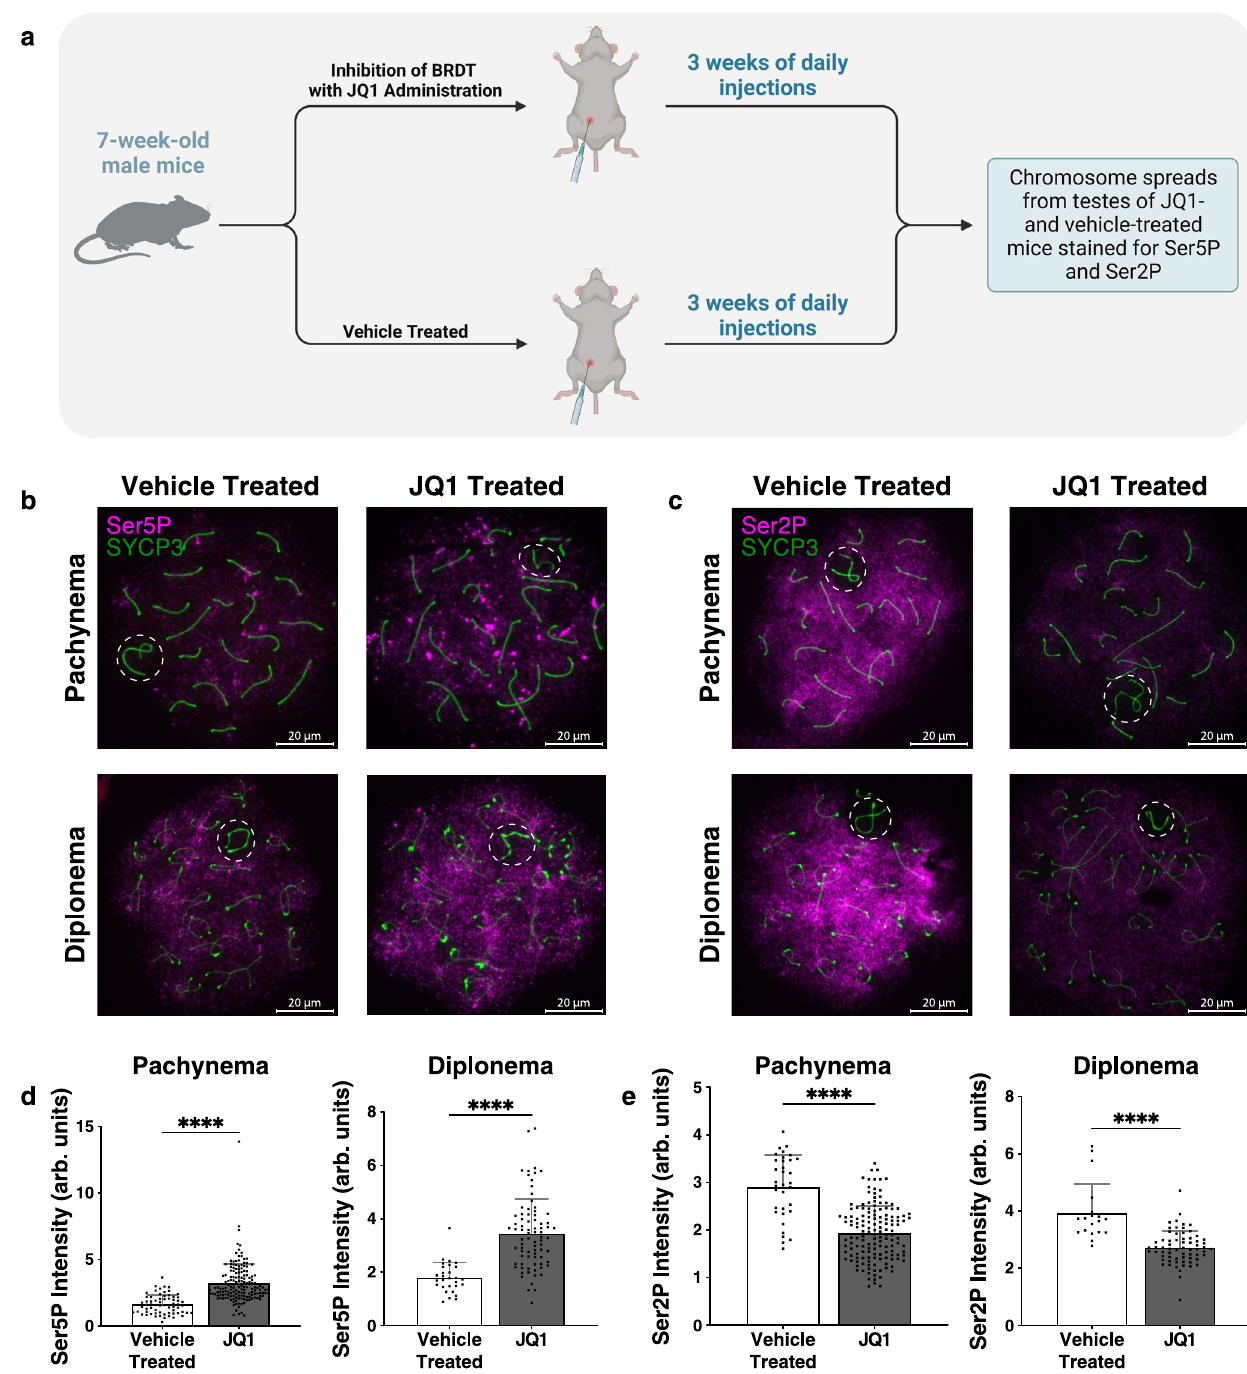
Fig. 5 | BRDT inhibition with the small molecule, JQ1, results in altered Pol II pause-release.a Schematicof experimentaldesignforinhibitionof BRDTwiththe smallmolecule,JQ1.7-week-oldmalemicewereinjectedintraperitoneally(i.p.)with JQ1 or vehicle solution daily for 3 weeks. Created with BioRender.com. b , c ImmunolocalizationofSYCP3(green)andSer5P( b )andSer2P( c )(magenta)in pachytene (top) and diplotene (bottom) spermatocytes from JQ1-treated and vehicle-treated male mice. The X and Y chromosomes are enclosed within white dotted circles. d , e Quanti fi cation of signal intensity for Ser5P and Ser2P